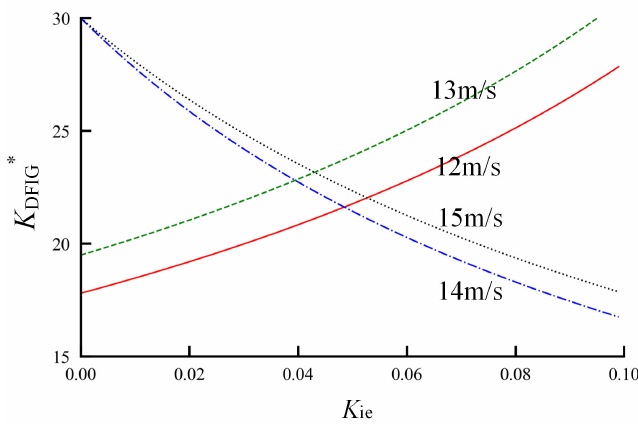
Figure 7. K DFIG with di ff erent K ie under di ff erent wind